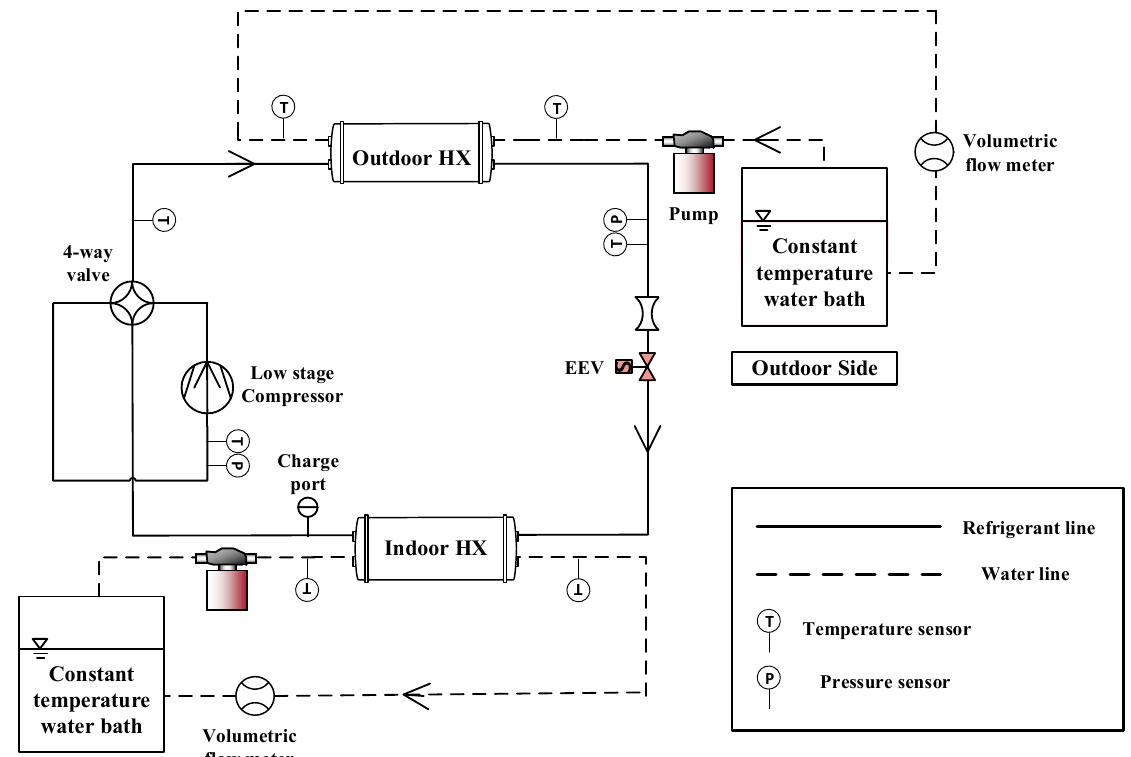
Figure 1. Schematic diagram of the heat pump. 116